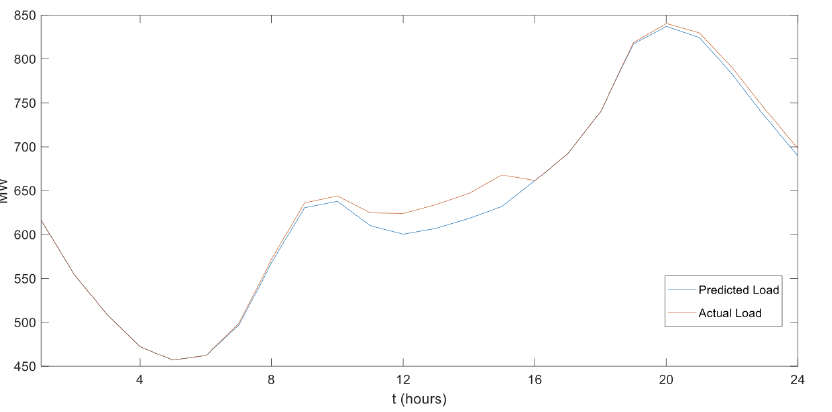
Figure 14. A realization of the real-time load forecast model for an energy-intensive winter day.